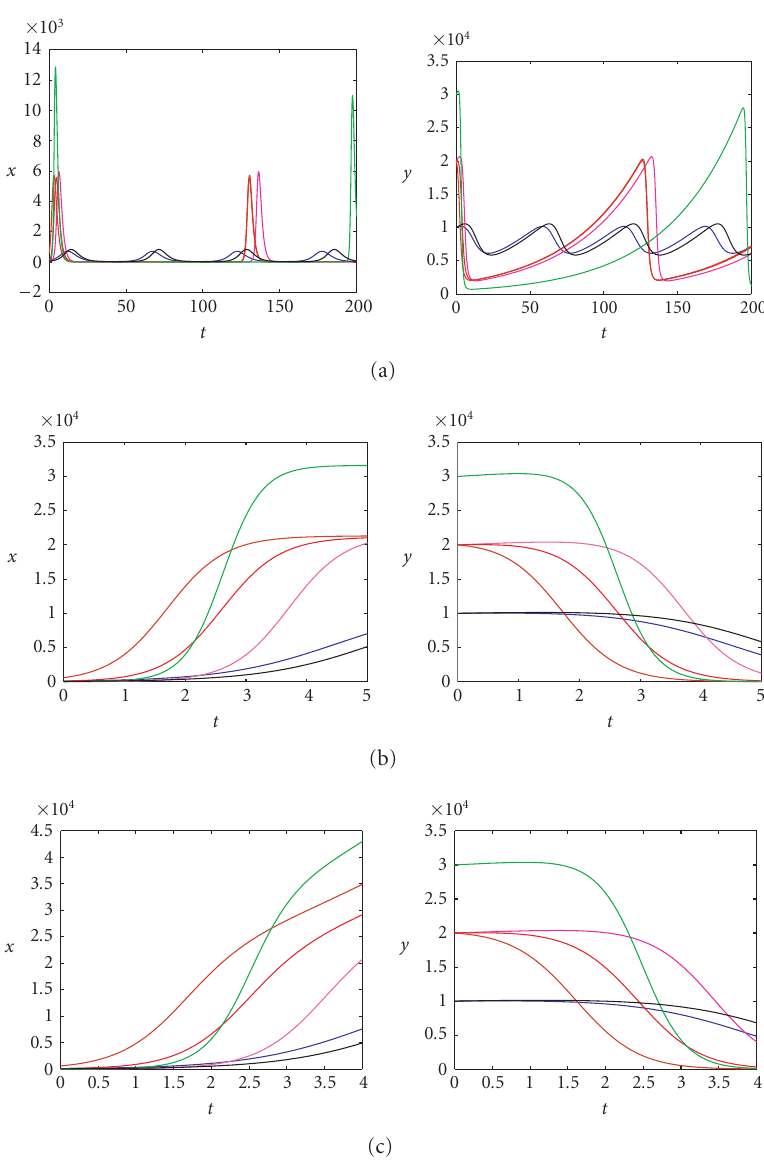
Figure 3.7. (a) Stable limit cycle behavior when c = 0 . 2 < 1. Note the soliton-like behavior in the dy- namics of the terrorist population (T) when the initial population of susceptibles (S) far exceeds that of T. The parameter values (except for the value of c ) are the same as those shown on the phase plot in Figure 3.6. (b) Time histories of the dynamics when c = 1 starting from di ff erent initial conditions. The parameters (except for the value of c ) are the same as those for Figure 3.7(a). The initial con- ditions (same as in Figure 3.7(a)) can be more clearly seen here. (c) Unstable behavior showing an explosion in the terrorist population for c = 1 . 2 > 1; the population of susceptibles declines to zero